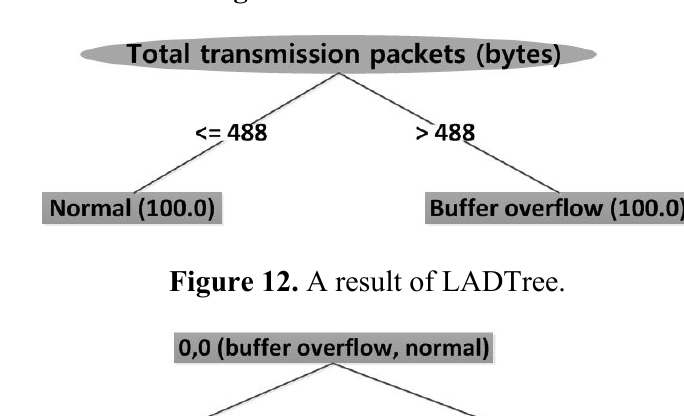
Figure 11. A result of J48.